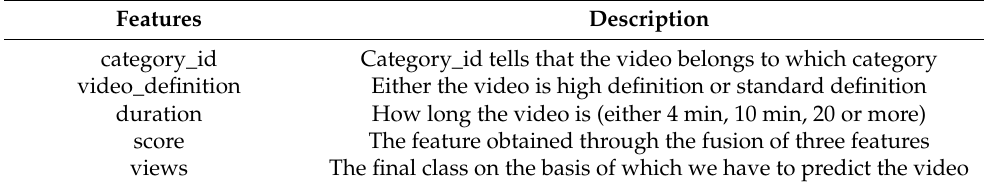
Table 3. Feature